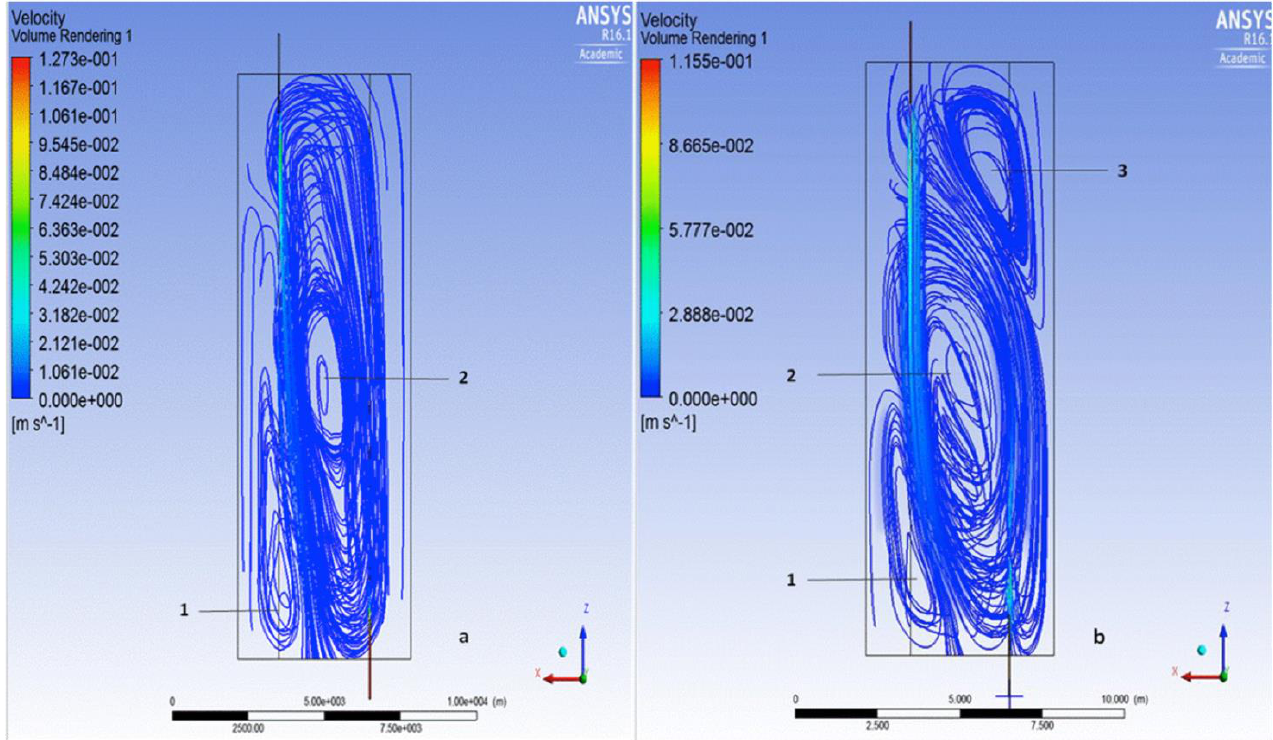
Figure 3. Velocity magnitudes and streamlines obtained with Fluent for the single-phase ( a ) and two-phase ( b ) models.